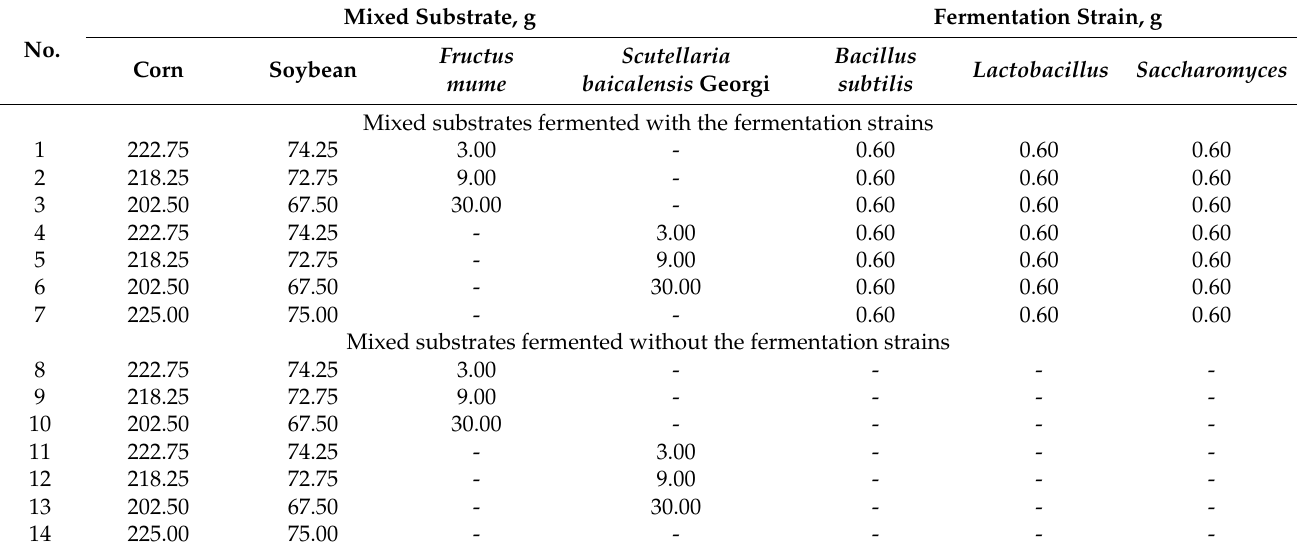
Table 1. The composition of fermented mixed